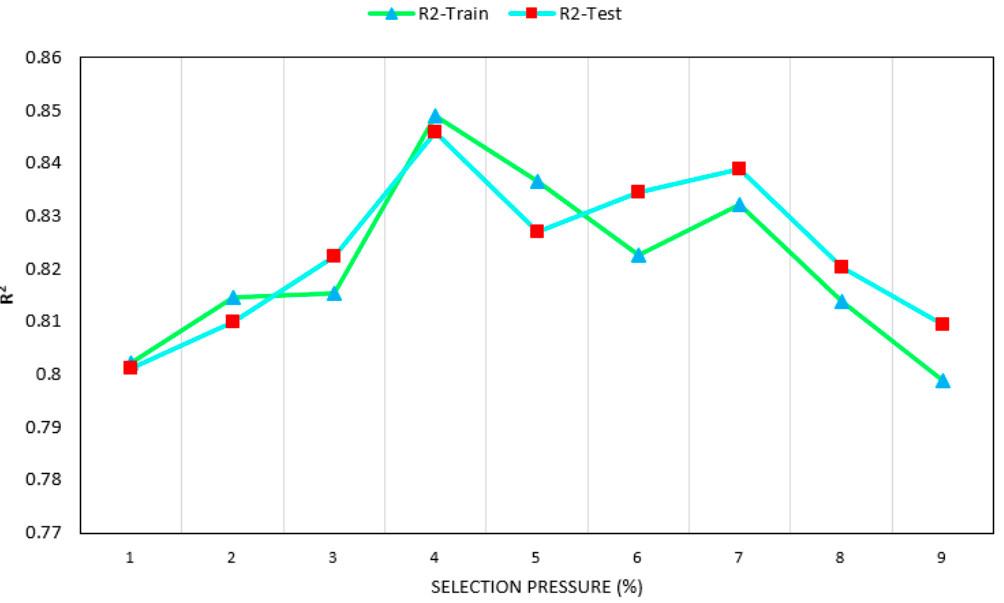
Figure 7. Impacts of various selection pressure on the performance of GMDH models.